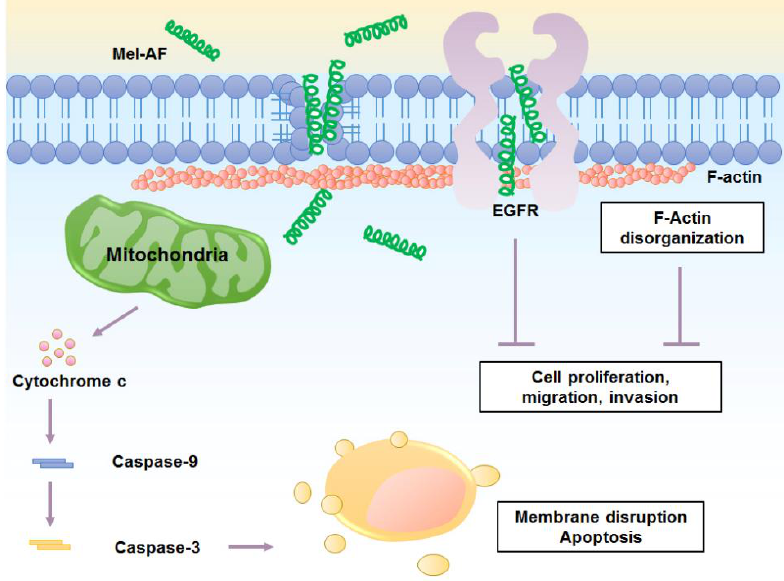
Figure 8. Mechanisms of anticancer activity of Mel-AF in human malignant melanoma cells.